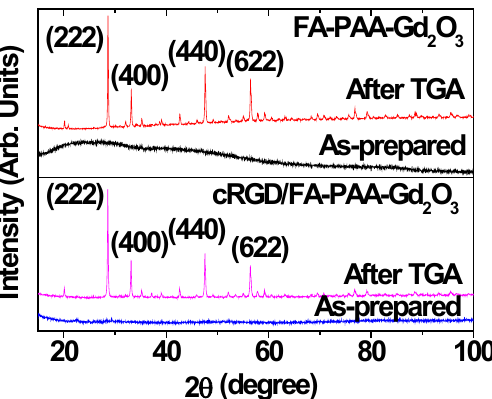
Figure 4. XRD patterns of the FA-PAA-Gd 2 O 3 and cRGD/FA-PAA-Gd 2 O 3 nanoparticles before (i.e., as-prepared) and after TGA. The representative assignments on XRD peaks after TGA are the (hkl) Miller indices of cubic Gd 2 O 3 . All observed peaks could be assigned with the (hkl) Miller indices of cubic Gd 2 O 3 .